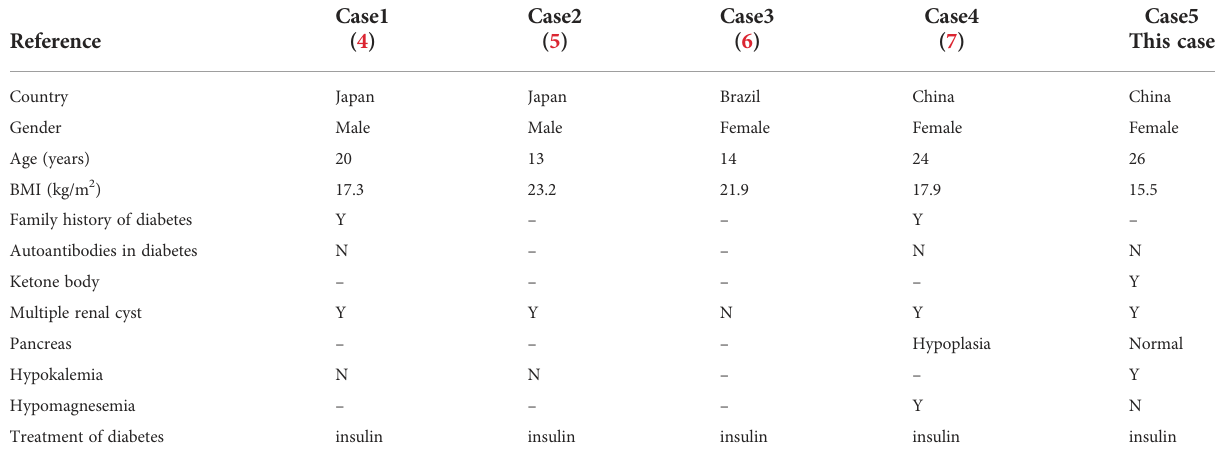
TABLE 3 Cases of HNF1B mutation (c.826C>T, p.Arg276*) in